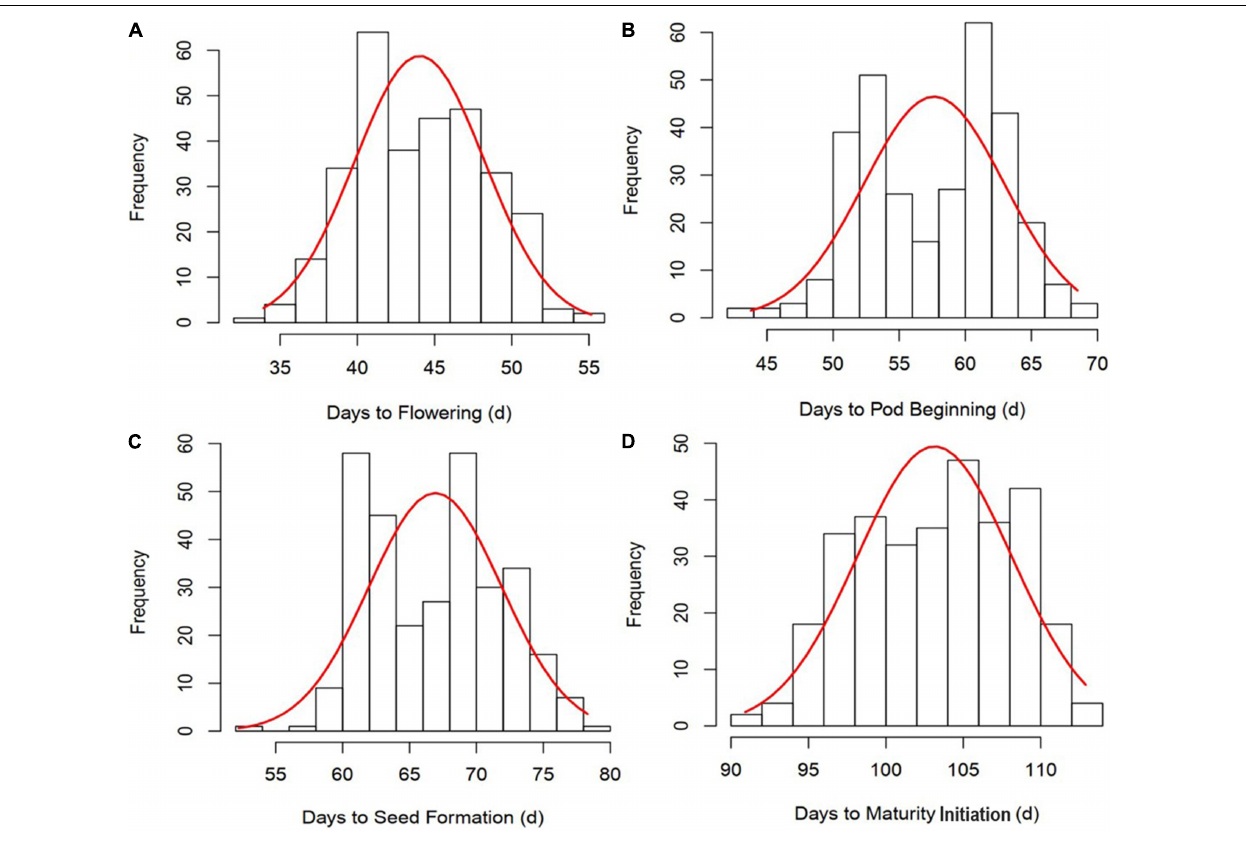
FIGURE 1 | Frequency distribution and correlation analysis of four growth stage traits (GSTs) best linear unbiased prediction values (BLUPs). (A–D) represent the frequency distribution of time to flowering, pod beginning, seed formation and maturity initiation, respectively.